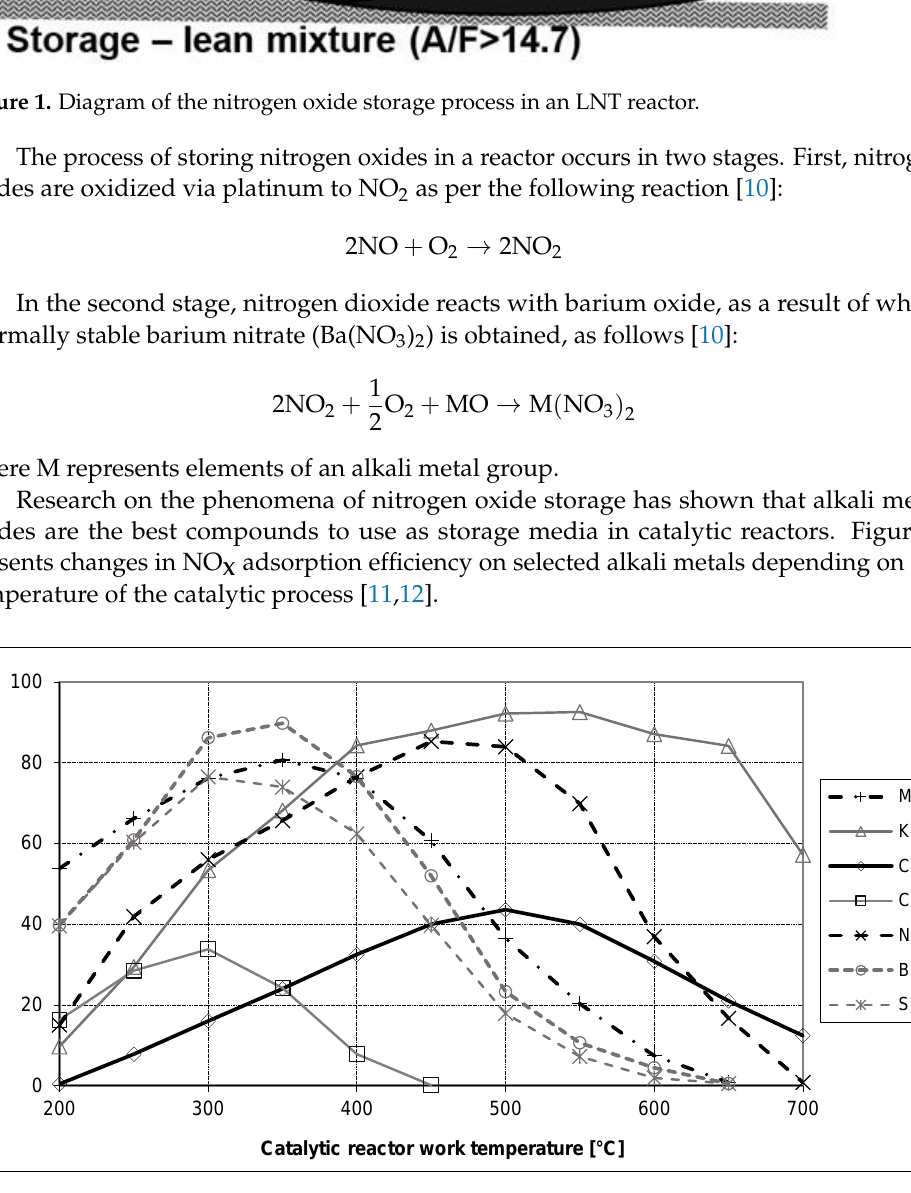
Figure 2. Nitrogen oxide adsorption efficiency for selected alkali metals [12] .